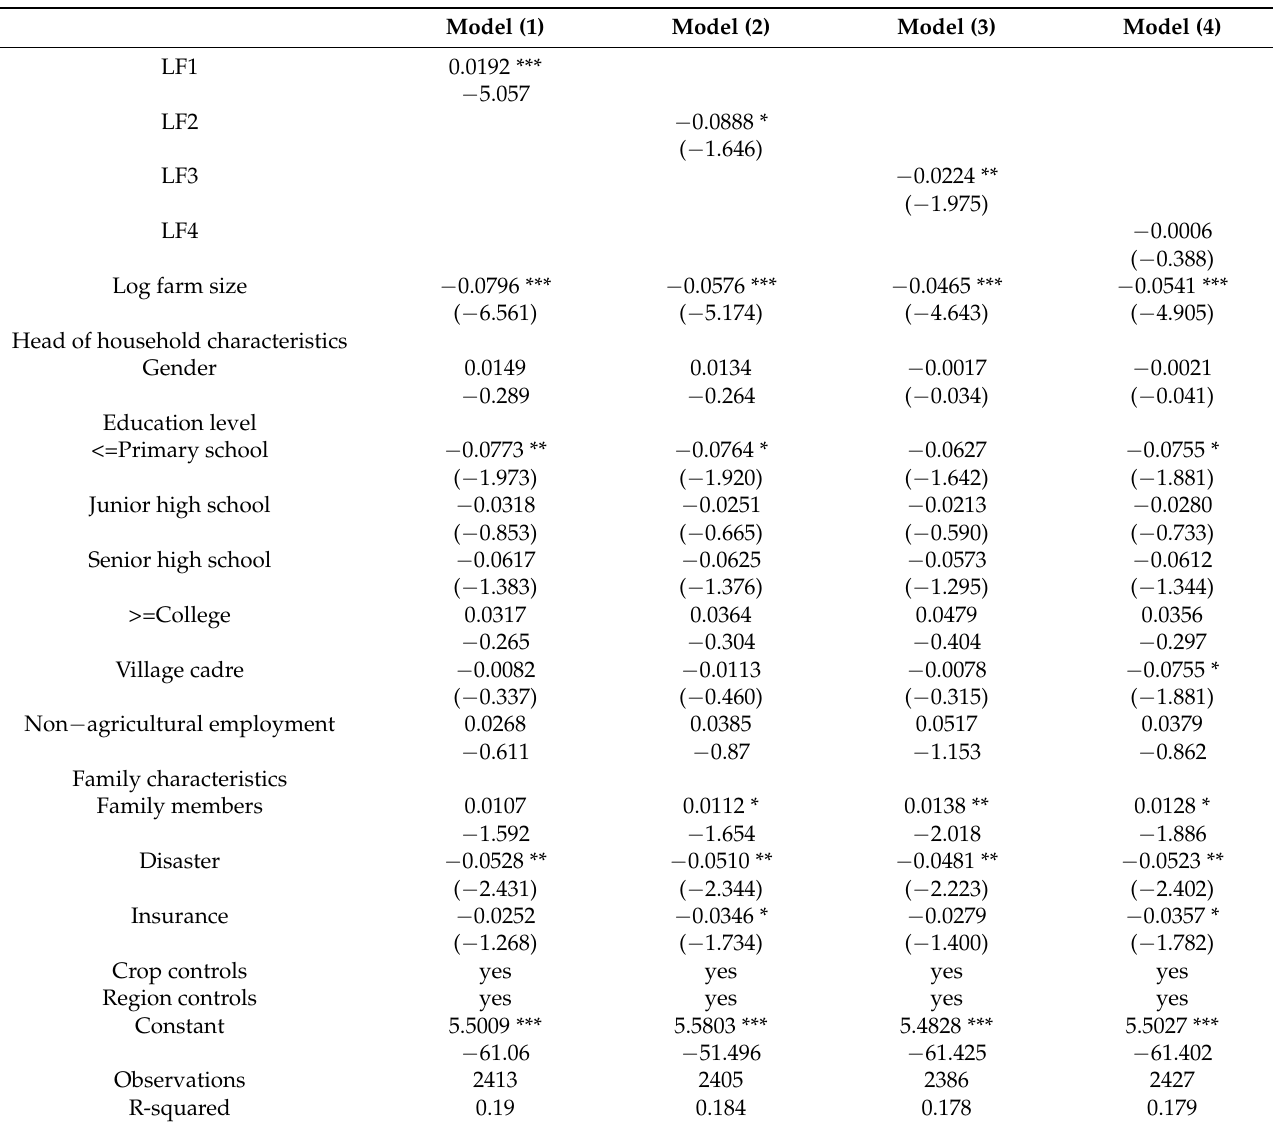
Table 3. Results of LF on production material